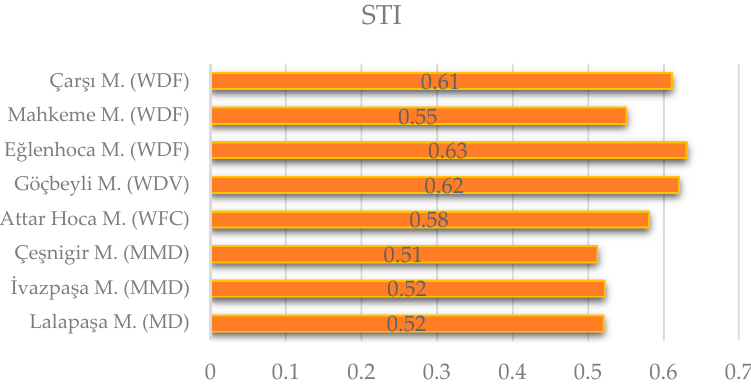
Figure 16. The average values of STI measured in the eight mosques.